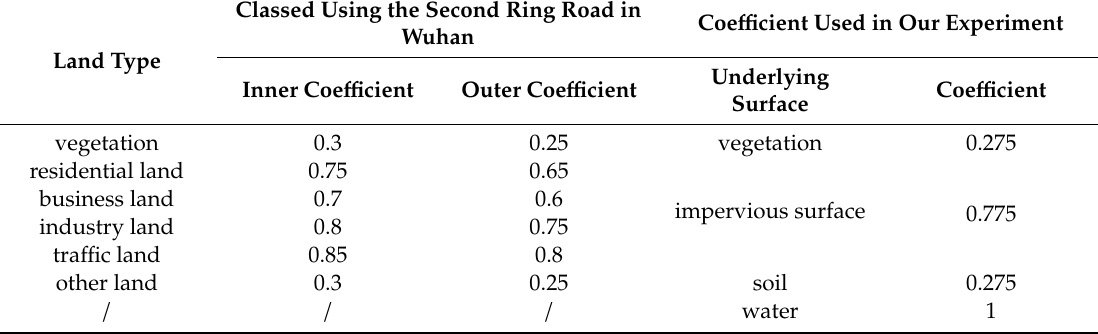
Table 3. Correspondence table for land-use type with reference to the Wuhan Municipal Flood Control and Drainage Regulations for the vegetation-impervious surface-soil and water (VIS-W)